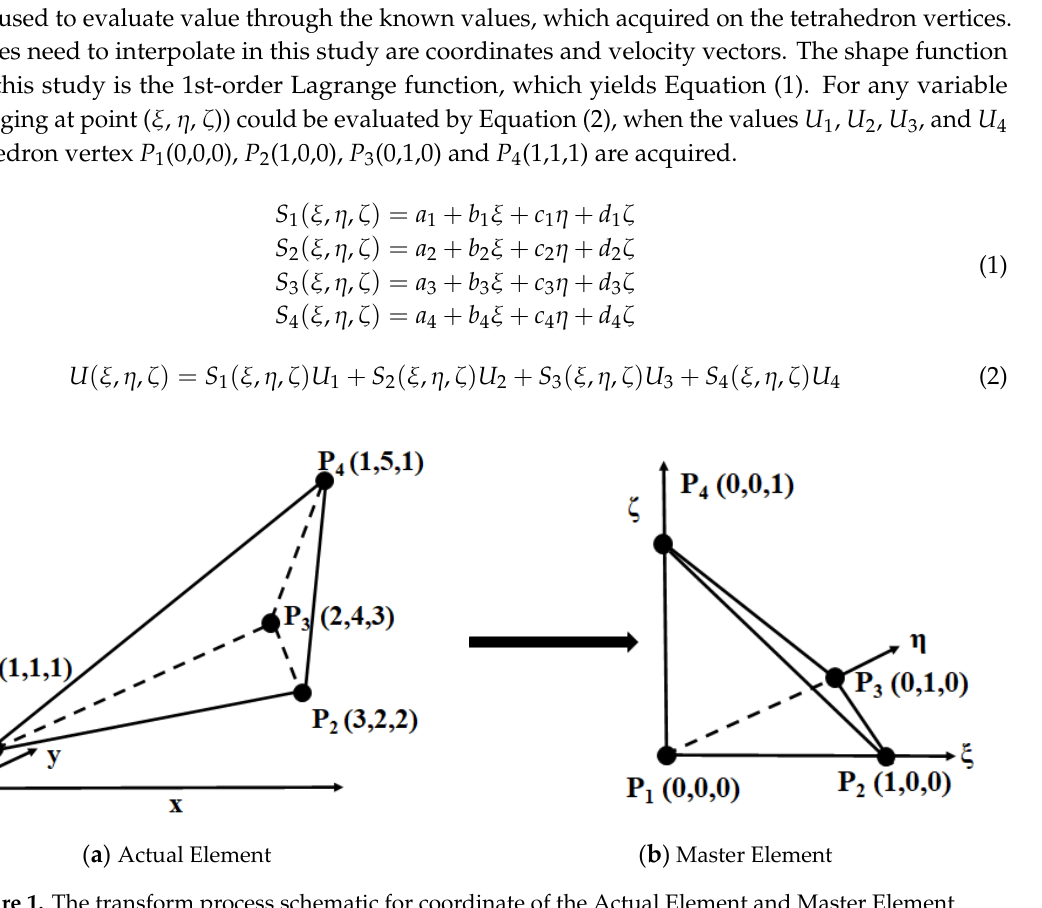
Figure 1. The transform process schematic for coordinate of the Actual Element and Master Element where ( a ) represents tetrahedron in the Actual Element and ( b ) represents the tetrahedron in the Master Element.